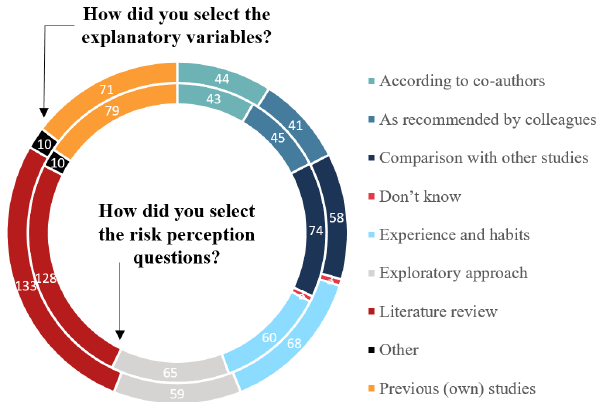
Figure 7. Responses to “How did you select the risk perception questions?” (inner circle) and “How did you select the explanatory variables?” (outer circle). These were multiple-choice